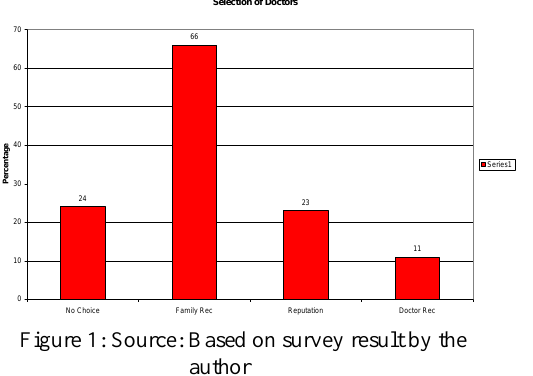
Figure 1: Source: Based on survey result by the author